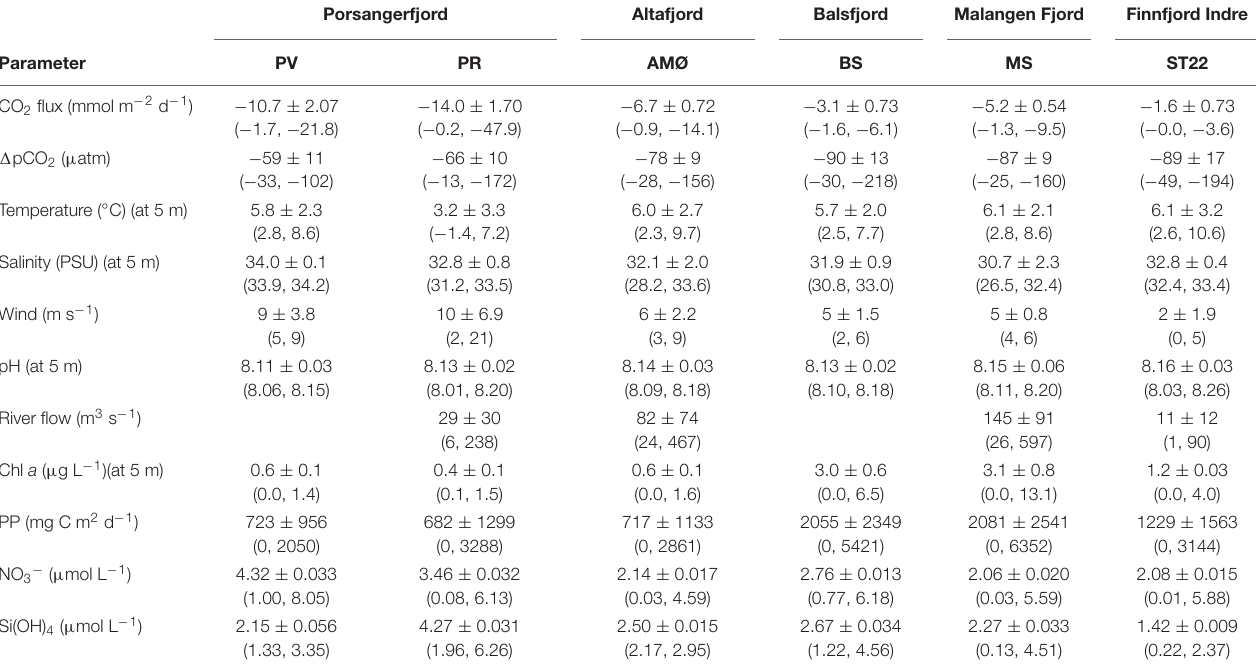
TABLE 3 | Summary of all the measured parameters.